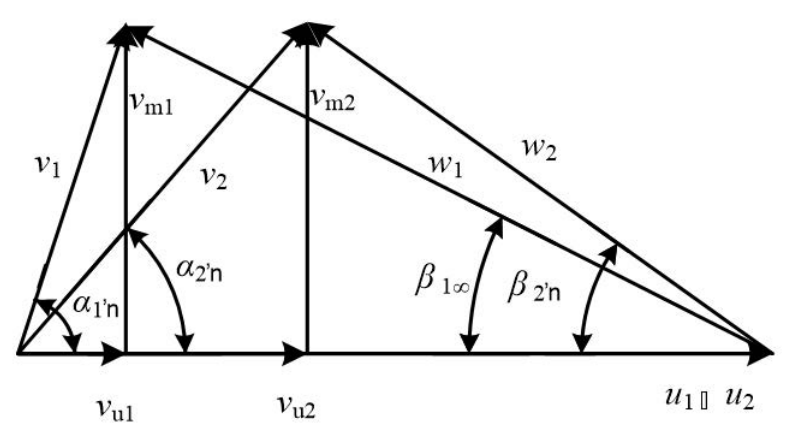
Figure 21. The velocity triangle of the